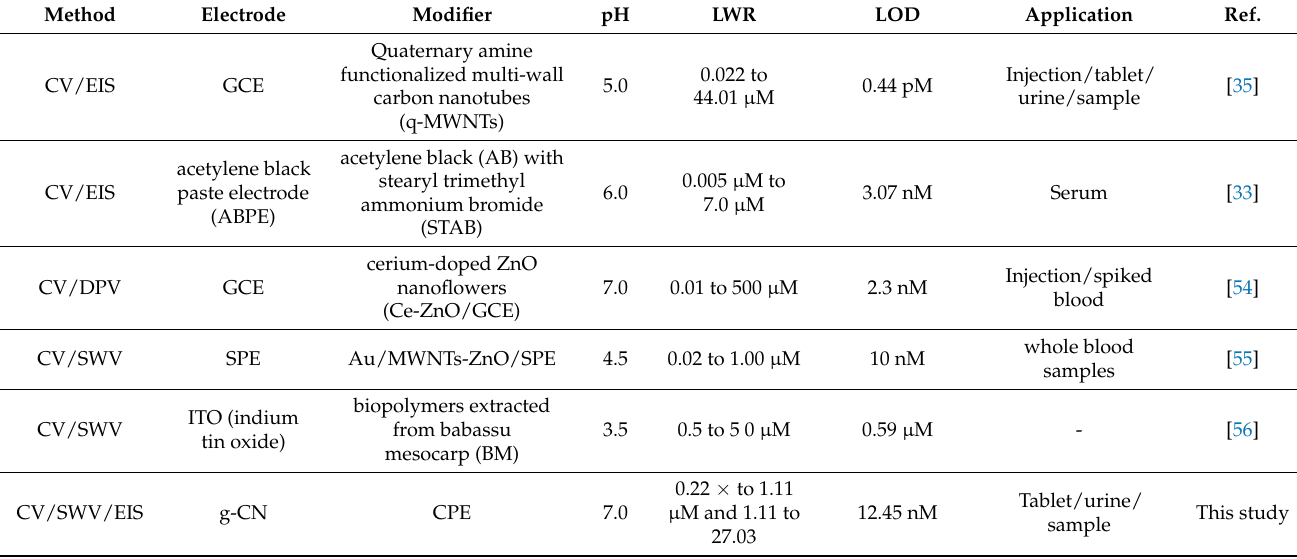
Table 4. Comparison between previous literature and our